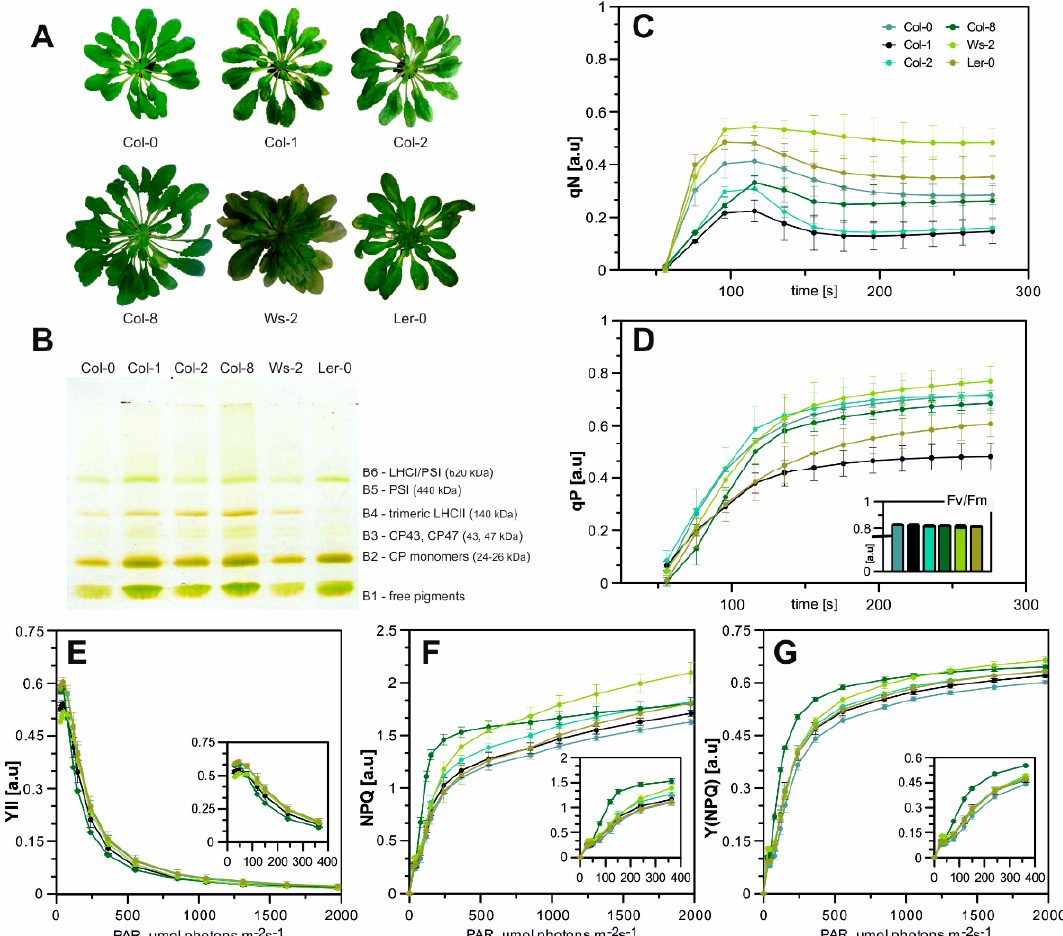
Figure 1. ( A )— A. thaliana accessions after 8–10 weeks of growth in hydroponic culture (plants were grown for 8–10 weeks in an 8 h photoperiod at 22 ◦ C/18 ◦ C (day/night) at PAR 110 µ mol photons m –2 s –1 ). ( B )—Native-PAGE separation of CP complexes from thylakoid complexes. The picture shows true colours; the numbering of green bands (B1-B6) is reported; 8.3 µ g of total chlorophyll was loaded into each well. The presented results are representative of at least five independent experiments. ( C )—Stress-induced limitation of NPQ (qN) and ( D )—photochemical fluorescence quenching (qP) of A. thaliana accessions; efficiency of PSII–Fv/Fm-insert bar chart, numerical values and SDs in Table A1. Error bars indicate standard deviations, n per measurement = 10. ( E – G ) Changes in photosynthetic parameters values. Small schemes indicate close-ups of the changes in the 0–400 PAR ( µ mol photons m − 2 s − 1 ) range. ( E )—Effective quantum yield of PSII, Y(II). ( F )—Non-photochemical quenching (NPQ). ( G )—Quantum yield of regulated energy dissipation in PSII, Y(NPQ) measured under increasing light intensities. Data are mean values ± SD from at least three independent